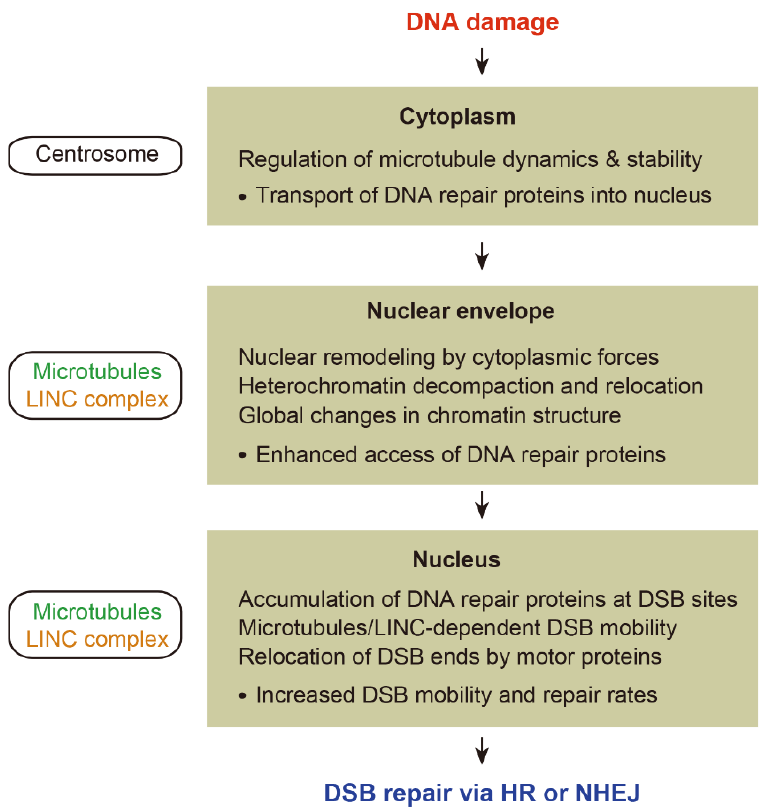
Figure 2. Overview of the role of microtubule dynamics in DNA damage response.